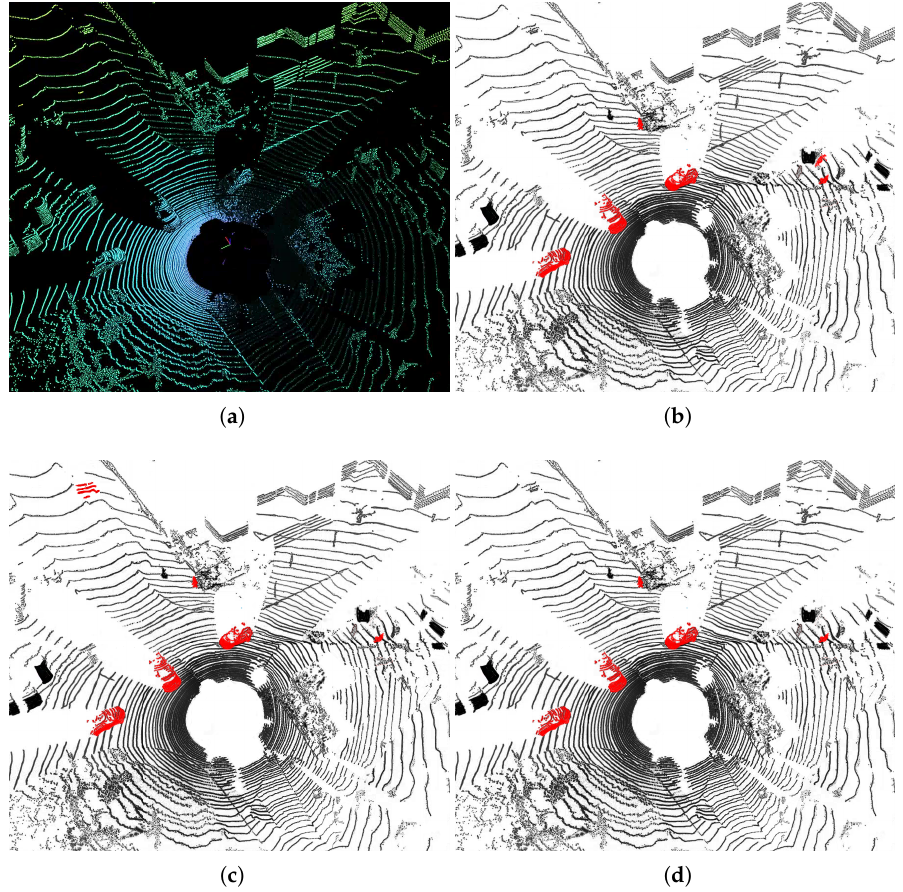
Figure 4. Qualitative results shown as point clouds. ( a ) Raw Point Cloud; ( b ) Ground Truth Labels, and ( c , d ) prediction results, where red points correspond to the class moving ( c ) LMNet; ( d )